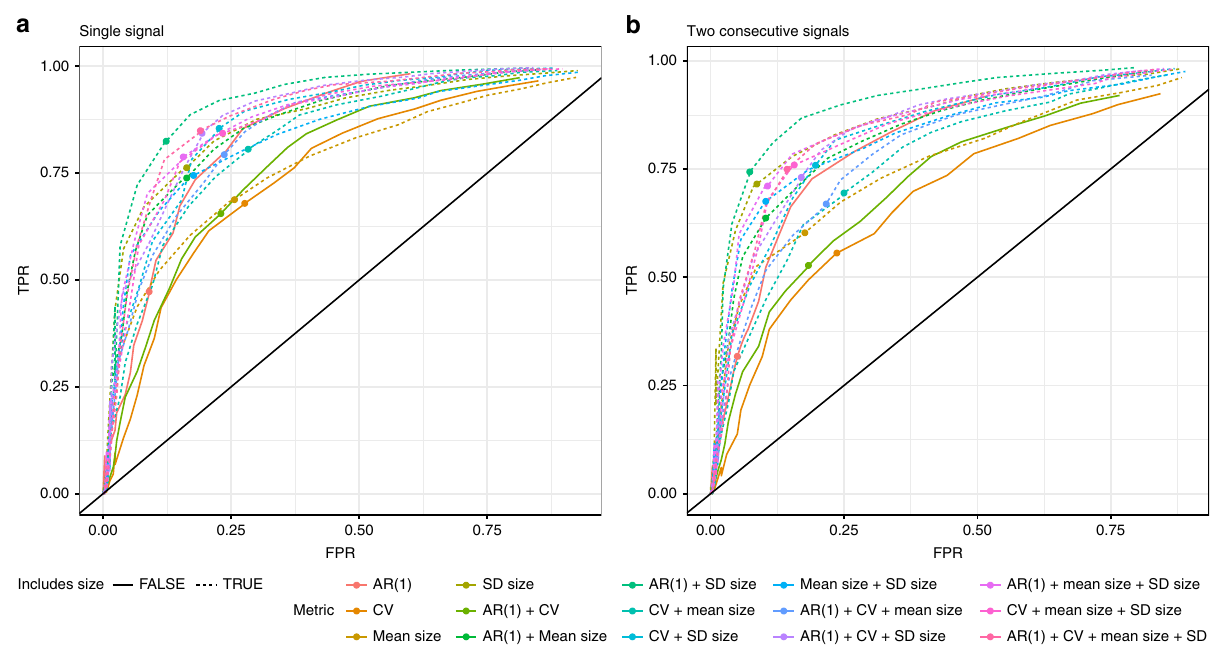
Fig. 7 Receiver Operator Characteristics (ROC) for the 15 early warning signals metrics. Where ( a ) a single signal over the threshold was considered a warning signal of recovery, and ( b ) when two consecutive signals were considered a warning signal of recovery across a range of threshold sigma values between 0.01 and 6. FPR = False Positive Ratio, TPR = True Positive Ratio. Points show the location on the curve corresponding to a 2-sigma threshold